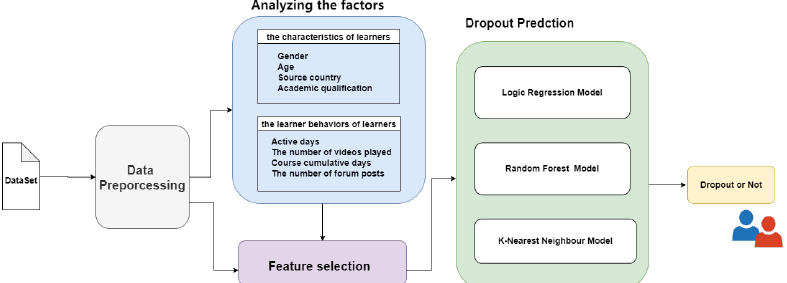
Figure 1. The framework of proposed dropout prediction